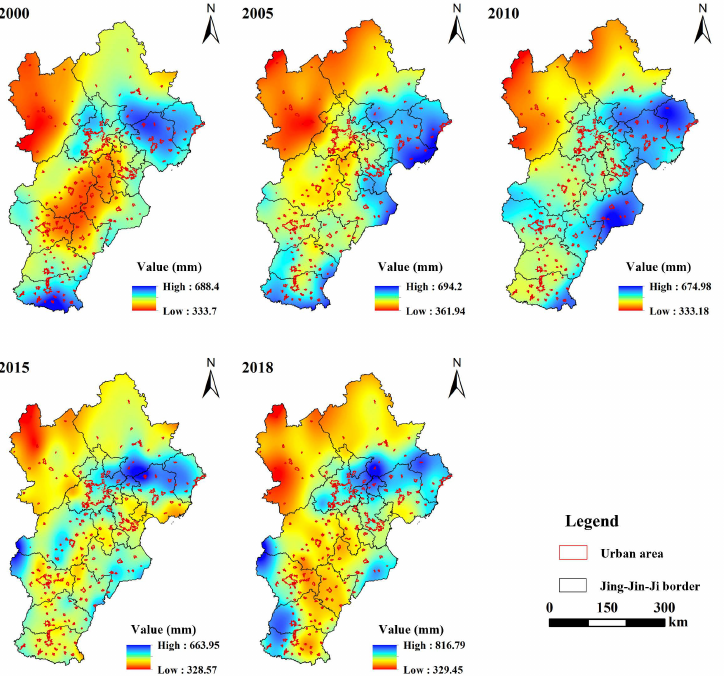
Figure 4. Spatial distribution of annual precipitation in different periods in the Beijing–Tianjin– Hebei region.